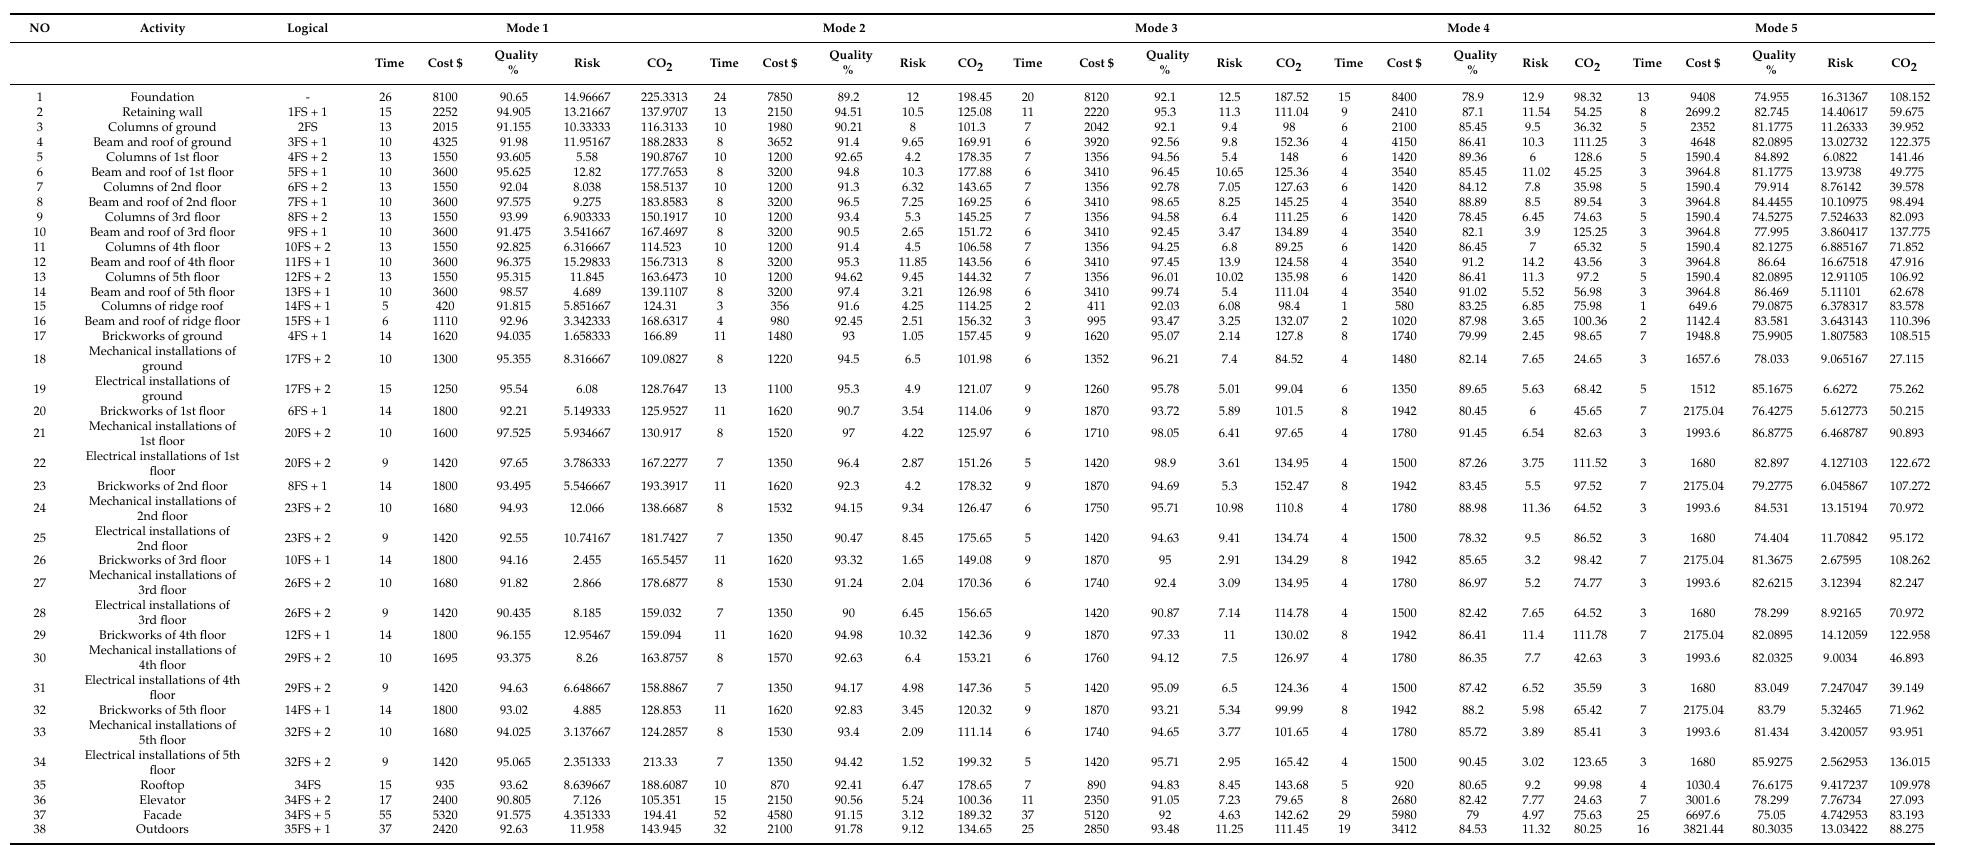
Table A1. Project data of case